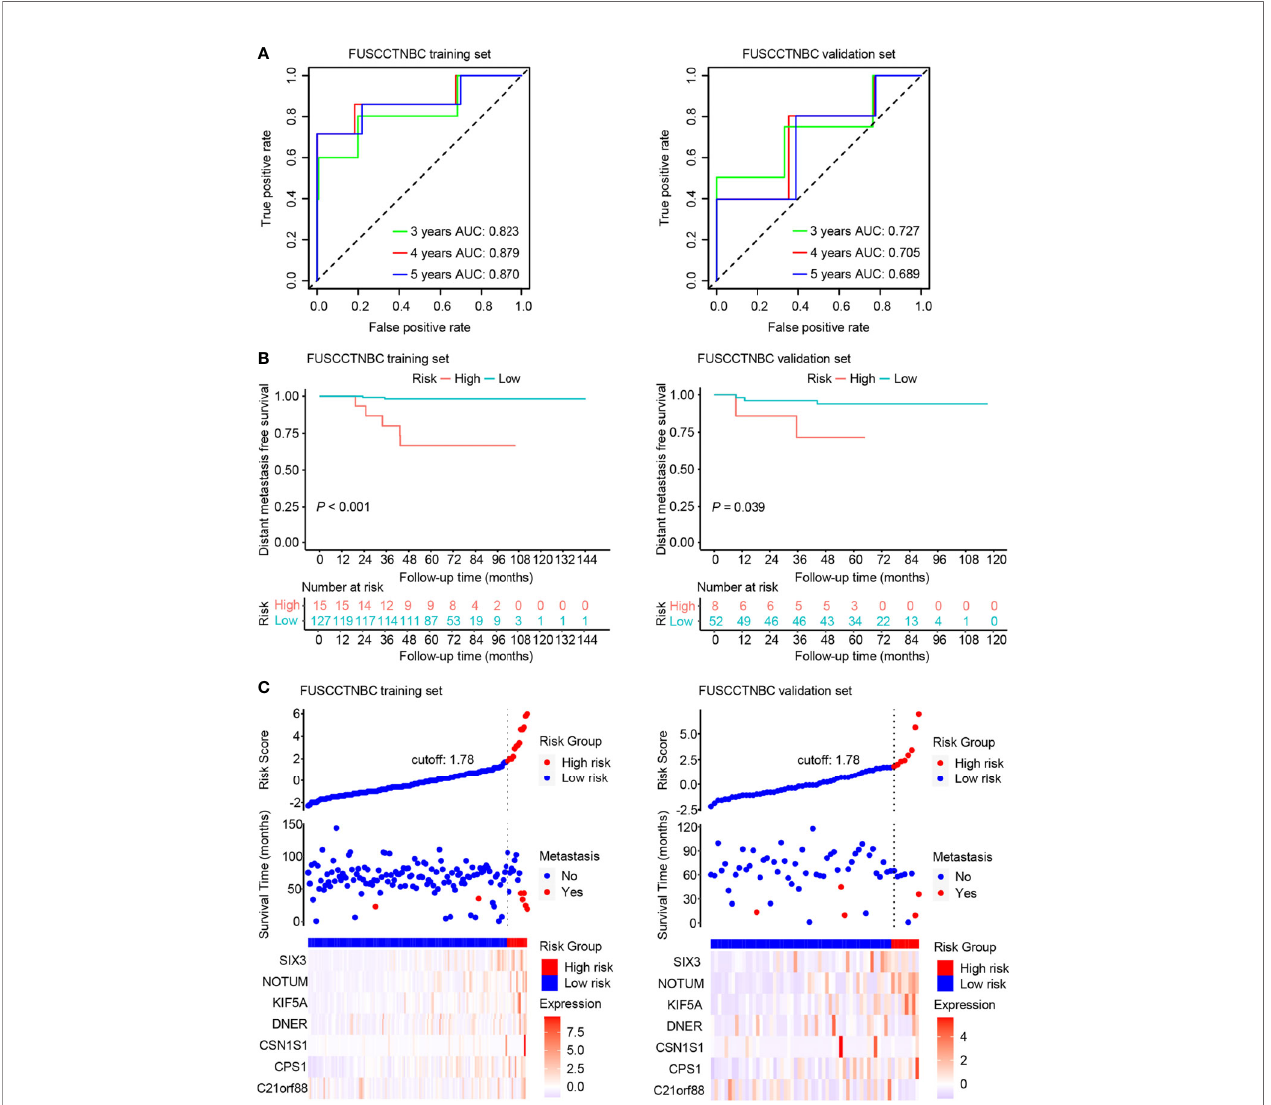
FIGURE 3 | Time-dependent receiver operating characteristic (ROC), Kaplan – Meier survival analysis, and risk score analysis for the seven-gene signature in the training set and validation set of the lymph node-negative triple-negative breast cancer (TNBC) cohort. AUC, area under the curve. (A) Time-dependent ROC curves of the seven-gene signature for 3-, 4-, and 5-year distant metastasis-free survival (DMFS). (B) Kaplan – Meier plots of the seven-gene signature illustrating that the patients in the high-risk group showed poorer DMFS than those in the low-risk group. (C) Distribution of genomic risk score, DMFS status of patients, and heat map of seven differentially expressed mRNA expression pro fi